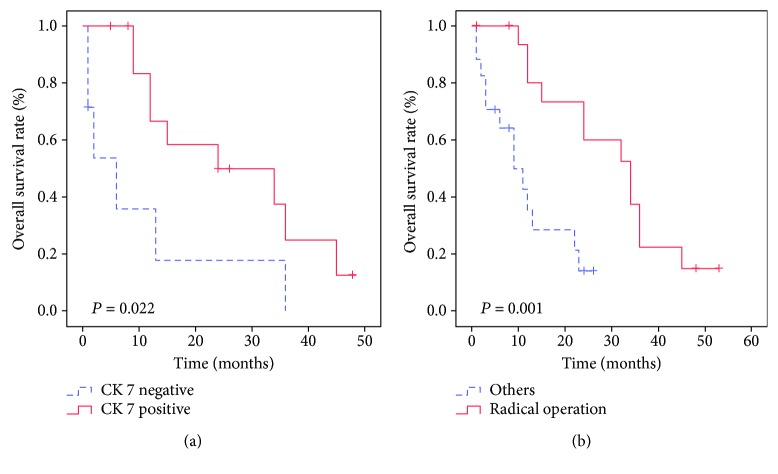
Prognostic values of cytokeratin 7 and radical operation in gastroenteropancreatic neuroendocrine carcinomas with liver metastasis. (a) The survival curve shows that the total survival rate of the cytokeratin 7-positive group is higher than that of the cytokeratin 7-negative group (p < 0.05). (b) The survival curve shows that the total survival rate of the radical operation group is higher than that of the other group (p < 0.05).